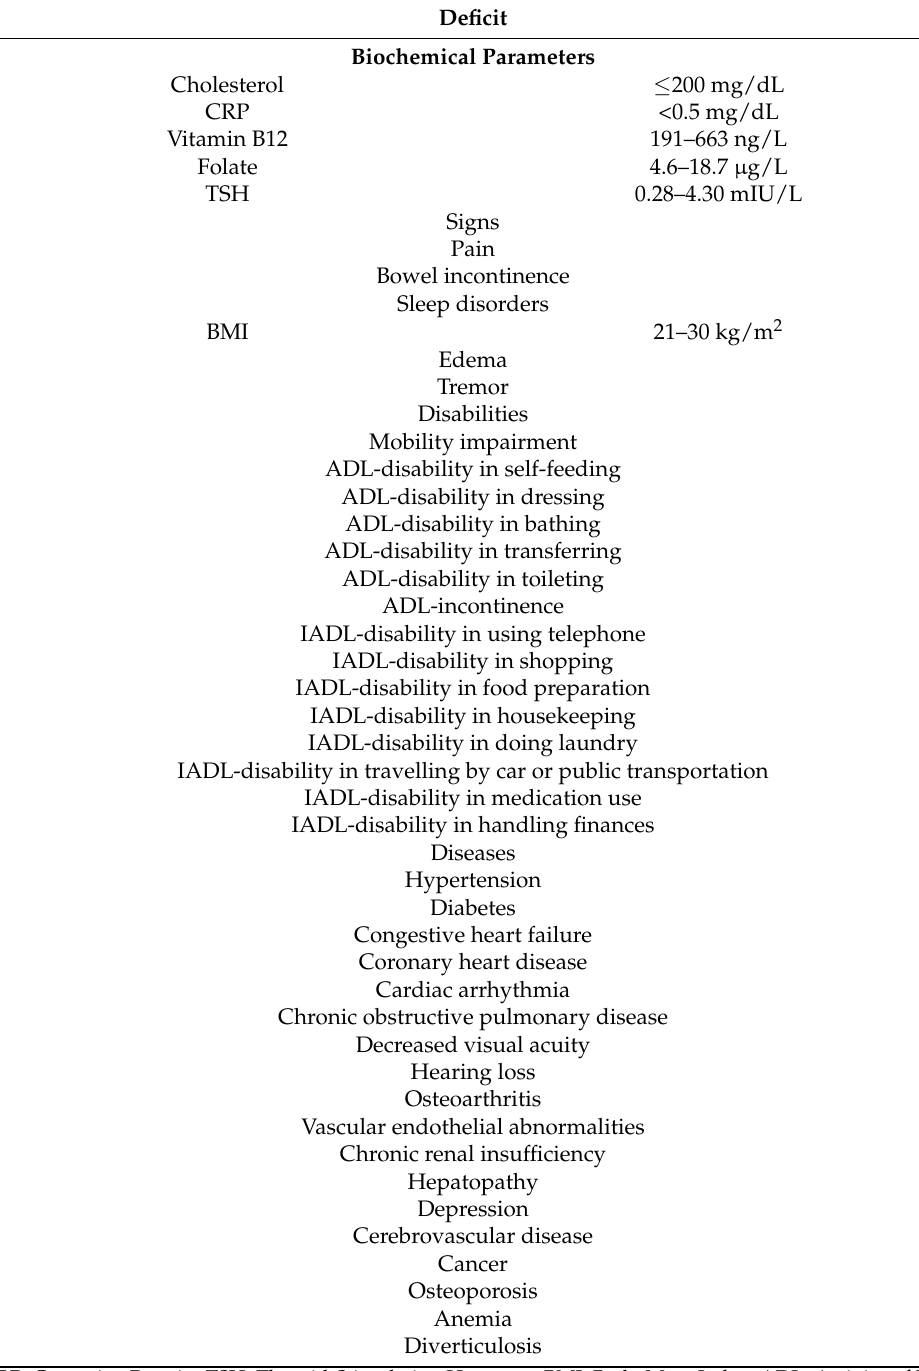
Table 1. List of the 44 biochemical and health deficits included in the